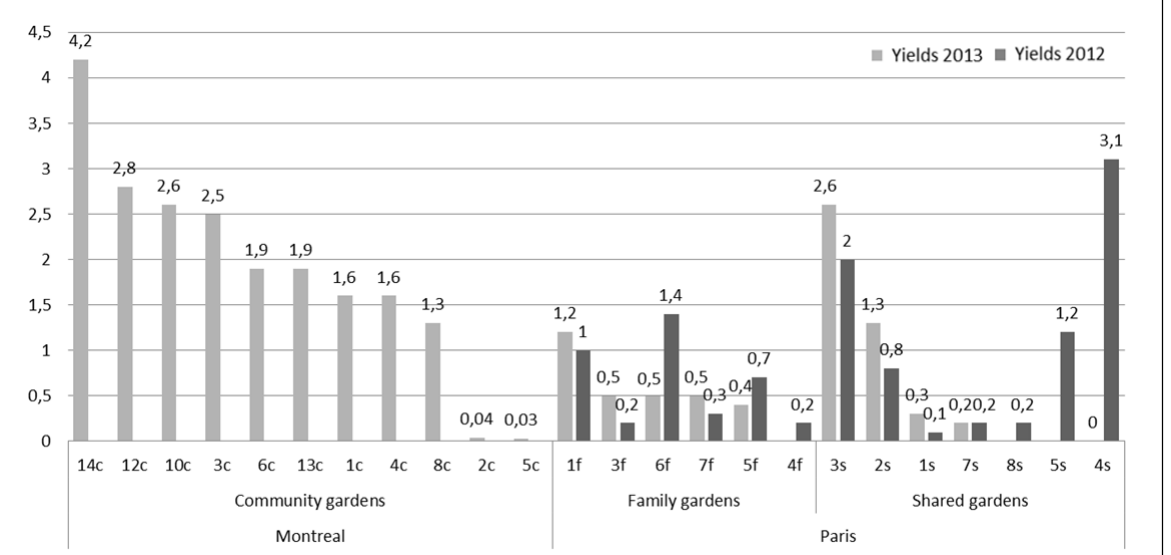
Figure 13b. Yield for Beans in 21 Collective Garden Plots (in kg/m 2